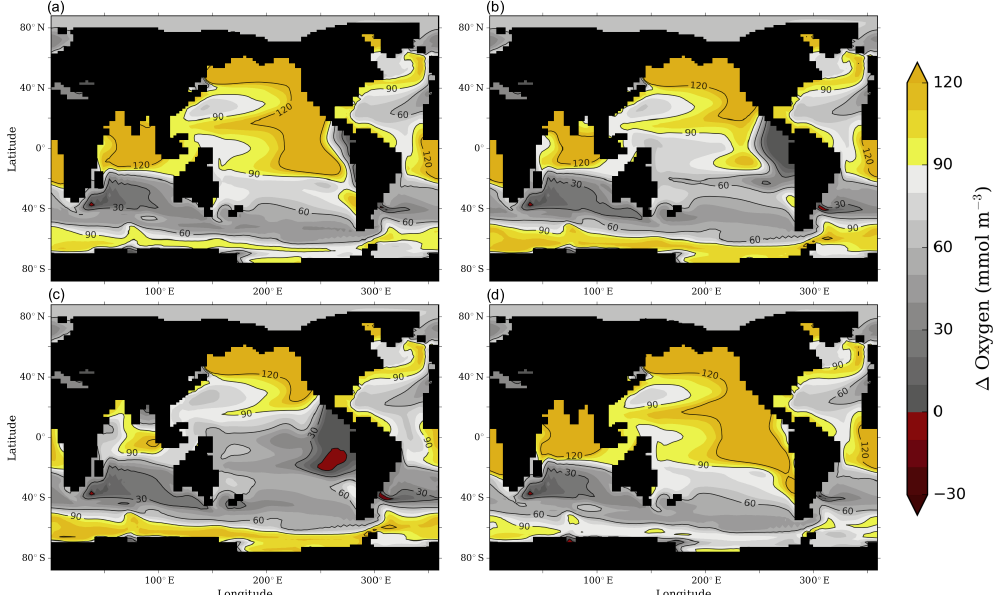
Figure 12. Change in oxygen concentration (mmolm − 3 ) at 500m between the LGM and PI for the experiments with modified biogeochem- − O-PI and (d) O-LGM BGC − O-PI. A depth of 500m ical formulations. (a) O-LGM BGC poc − O-PI, (b) O-LGM BGC rem − O-PI, (c) O-LGM BGC pic all is representative of the depth at which the greatest extent of low-oxygen water exists in the simulated PI climate. It should be noted that the oxygen field for experiment O-LGM BGC , whereby particulate inorganic carbon was set to zero, did not differ from the unmodified glacial pic experiment O-LGM and can therefore be used here as a reference to that